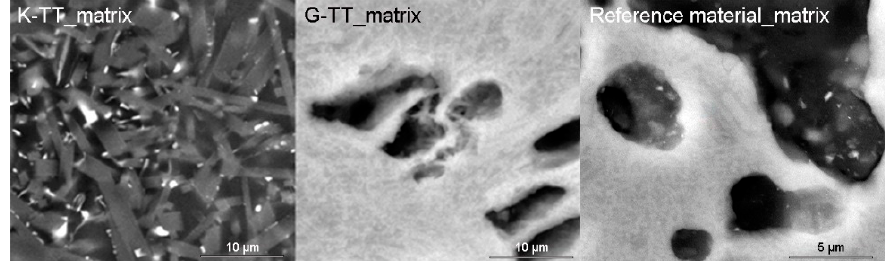
Figure 4. Sample G-T–interface of large, fired clay nodule and mixture of fired clay and fragments of fused mullite.